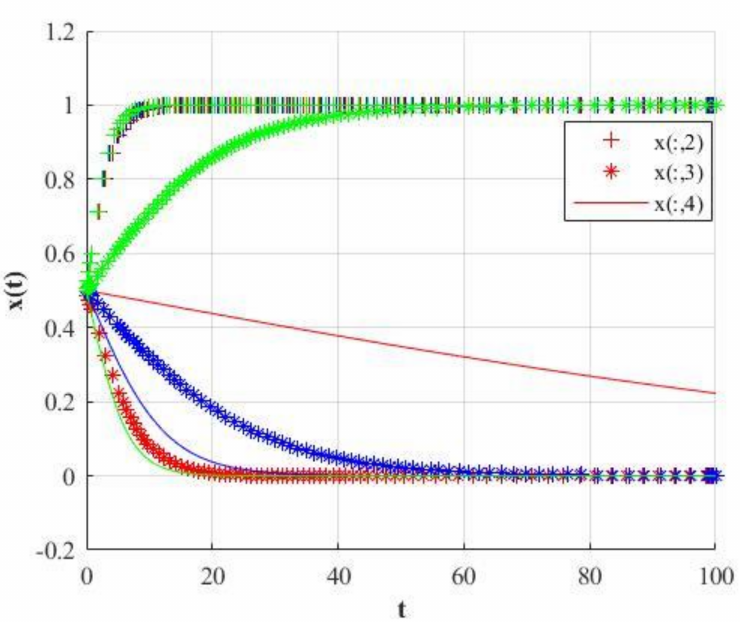
Figure 24. Change the parameter δ 2 and δ 3 , and their values are (0.8, 0.2) (red curve), (0.5, 0.5) (blue curve), and (0.2, 0.8) (green curve) so as to take the value of the three-way strategy evolution